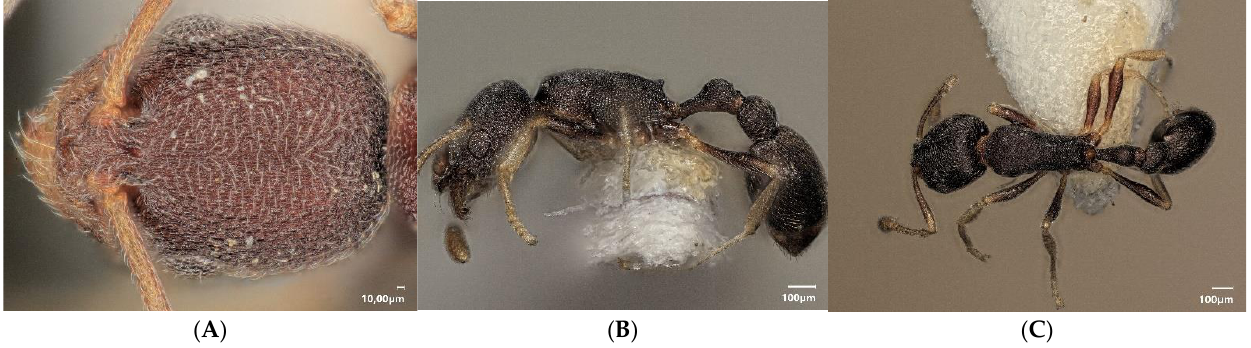
Figure 7 Cardiocondyla opaca, holotype: head in dorsal view ( A ), lateral view ( B ), dorsal view ( C ).